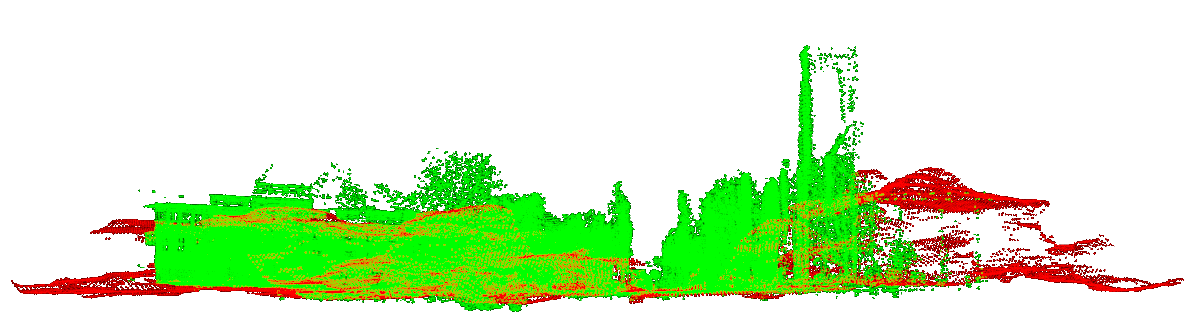
Figure 9. Result of fusion with standard ICP without surface smoothing. Side view presentation of same dataset as shown in fig. 8 (top) in a monochrome colors (green: LiDAR point cloud, red: landscape model derived from satellite images). One can notice the increased point density at the horizontal road’s level, and also the large inaccuracy of the satellite height measurements at the